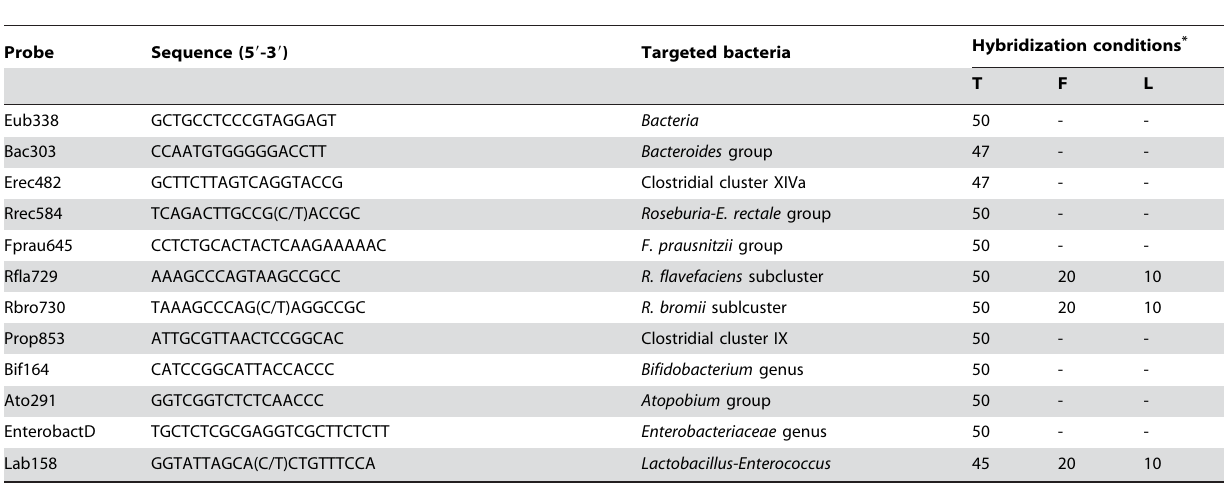
Table 9. Oligonucleotide probes and hybridization conditions used in this study.